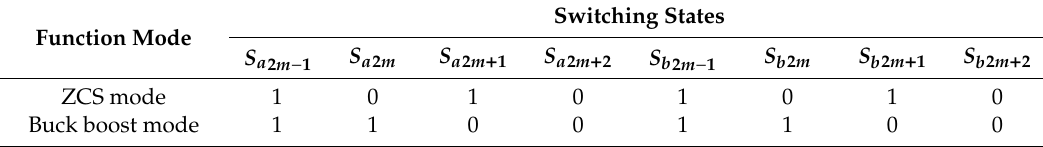
Table 1. Switches control logical